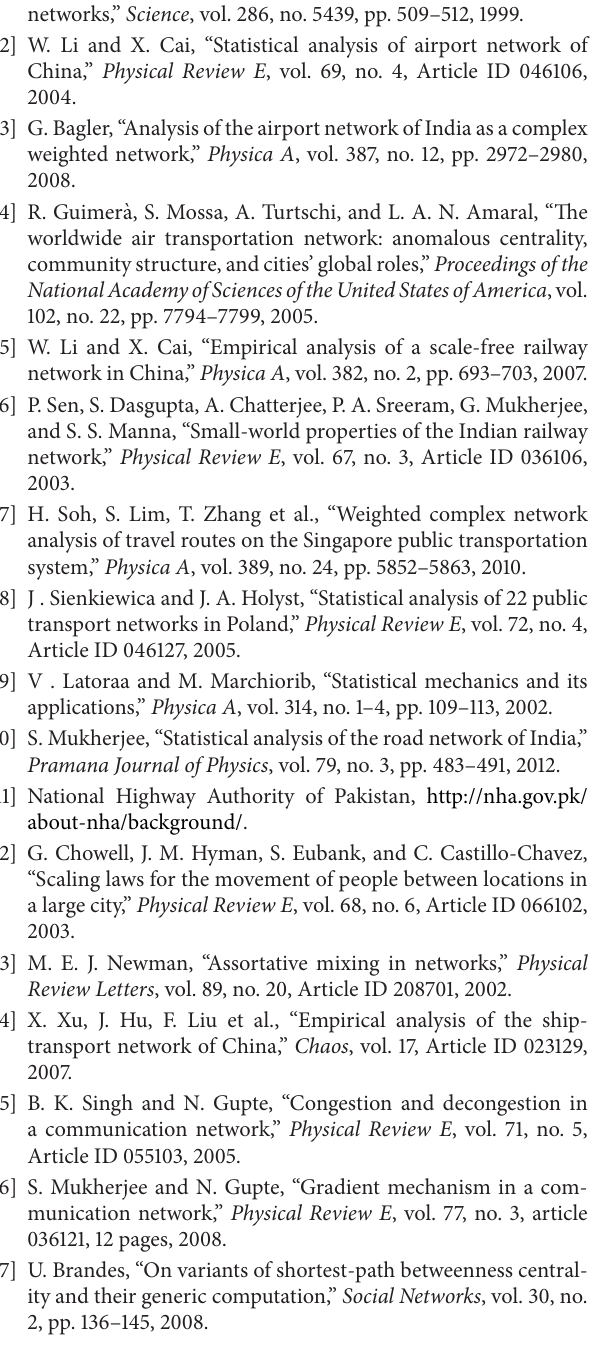
Table 2: Top ten cities identified based on betweenness centrality. Betweenness